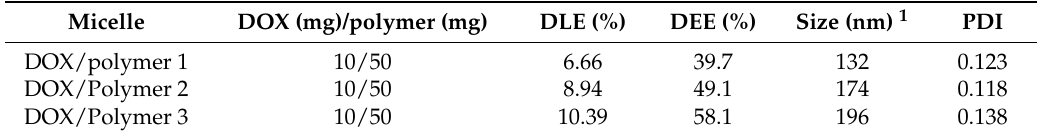
Table 2. Characteristics of DOX-loaded polymer micelles.